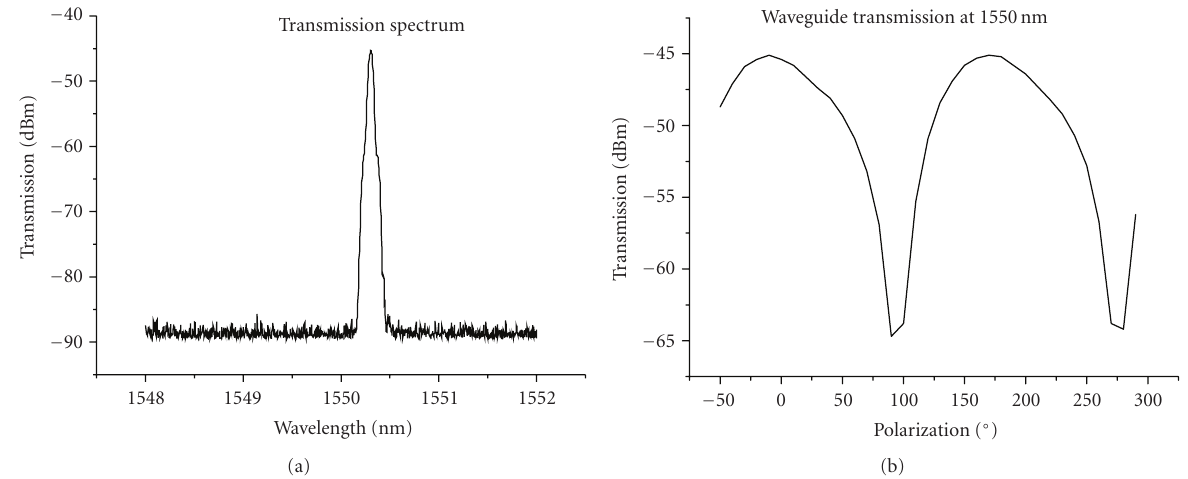
Figure 5: (a) The spectrum of the transmitted mode. (b) Graph showing the dependency of transmission through the waveguide on polarization — a characteristic of the DLSPPW mode.